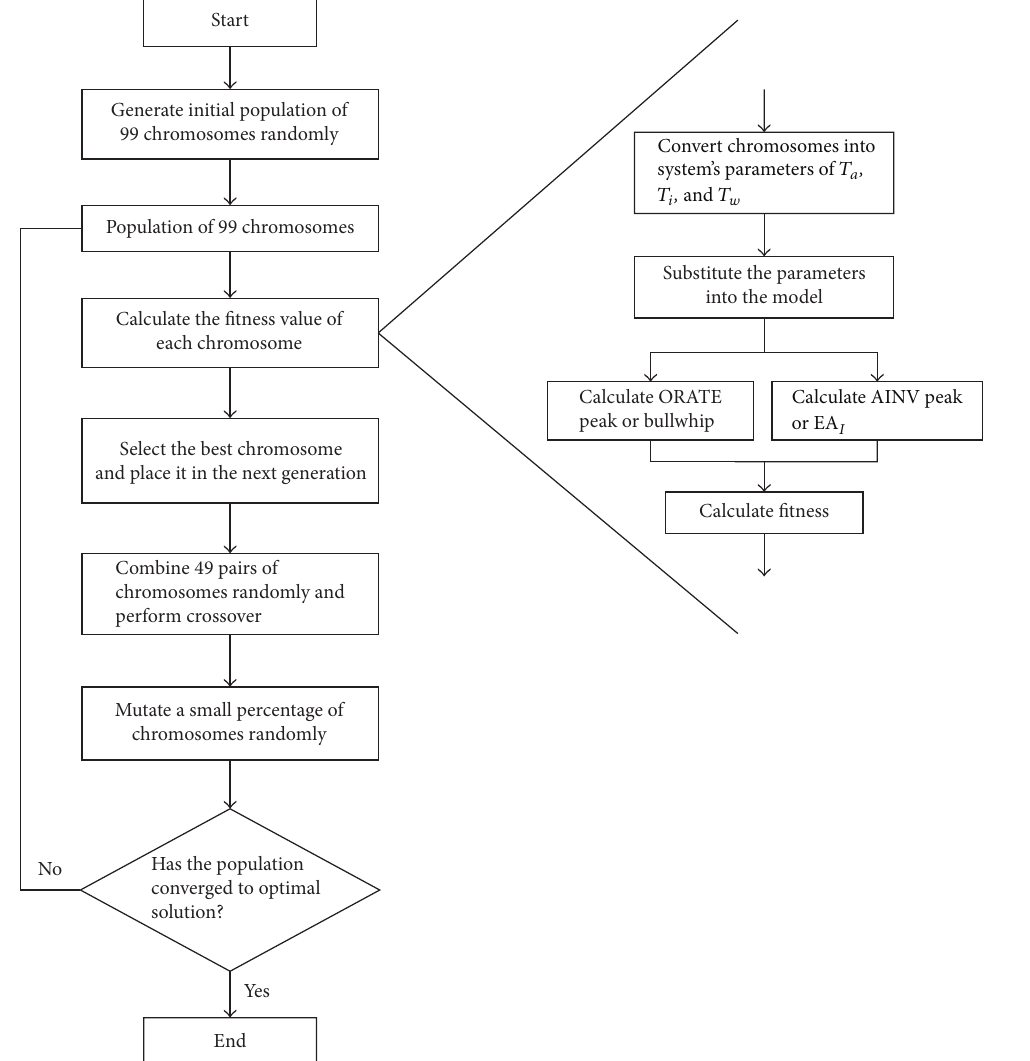
Figure 11: The optimization procedure under the GA.